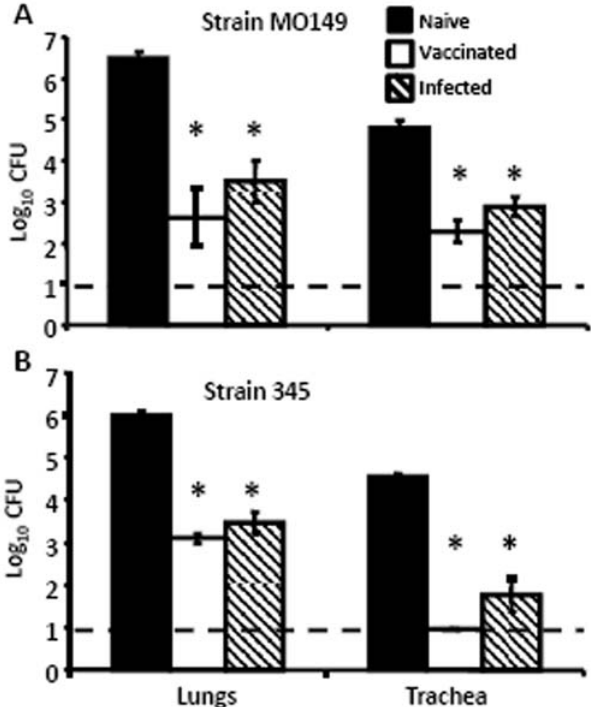
Figure 7. Human isolated, Complex IV B. bronchiseptica colonization of B.pertussis -immune mice. Groups of 4 naı¨ve (black bars), B. pertussis -vaccinated (white bars) or B. pertussis -convalescent (hatched bars) C57BL/6 mice were challenged with B. bronchiseptica strain (A) M0149 or (B) 345 and dissected Day 3 post-challenge. Bacterial numbers are represented as the mean Log 10 CFU + / 2 SEM. Dashed line indicates the lower limit of detection. * indicates statistical difference ( P value of , 0.05) between naı¨ve and treated groups.